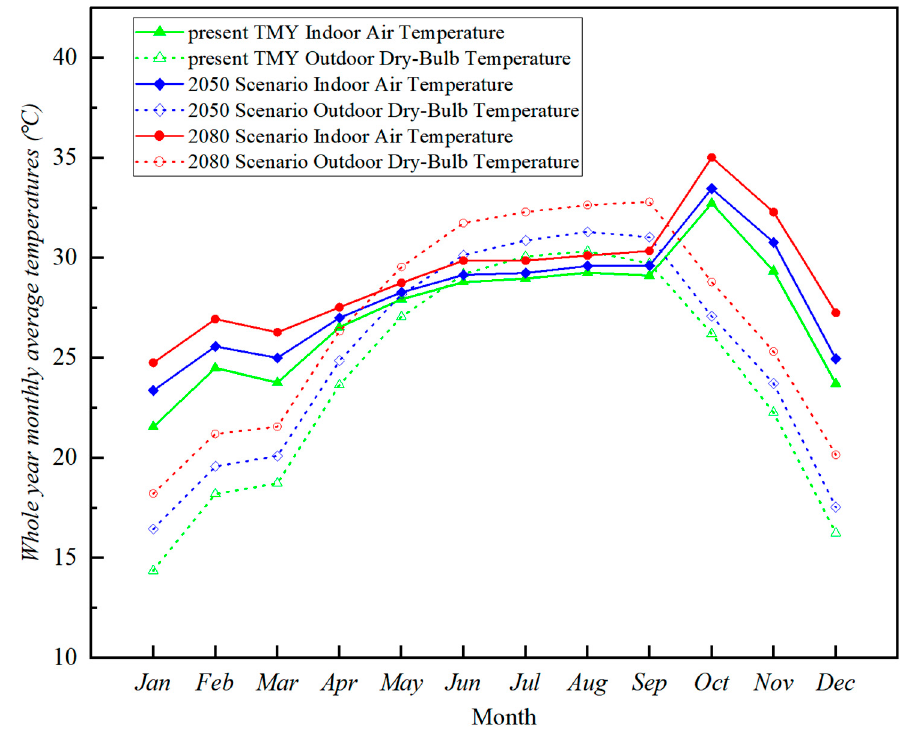
Figure 13. Whole year monthly average temperatures of present TMY and predicted future scenarios (2050 and 2080).